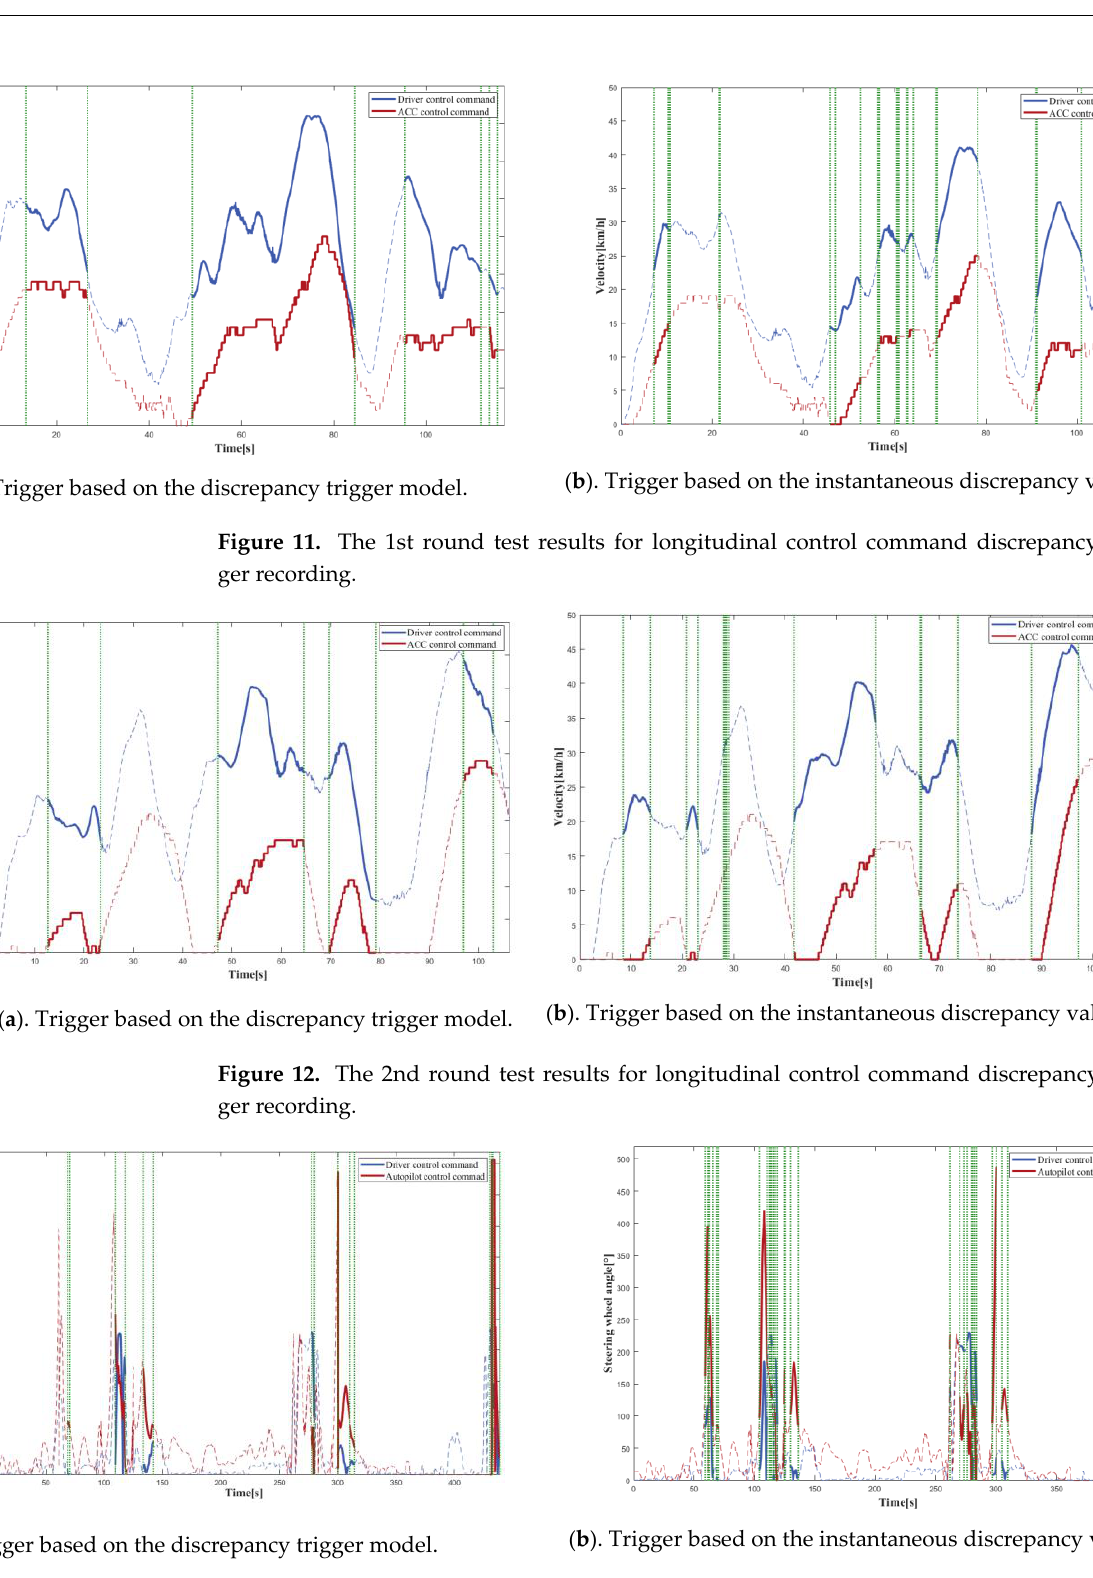
Figure 13. The 1st round test results for lateral control command discrepancy data trigger recording.